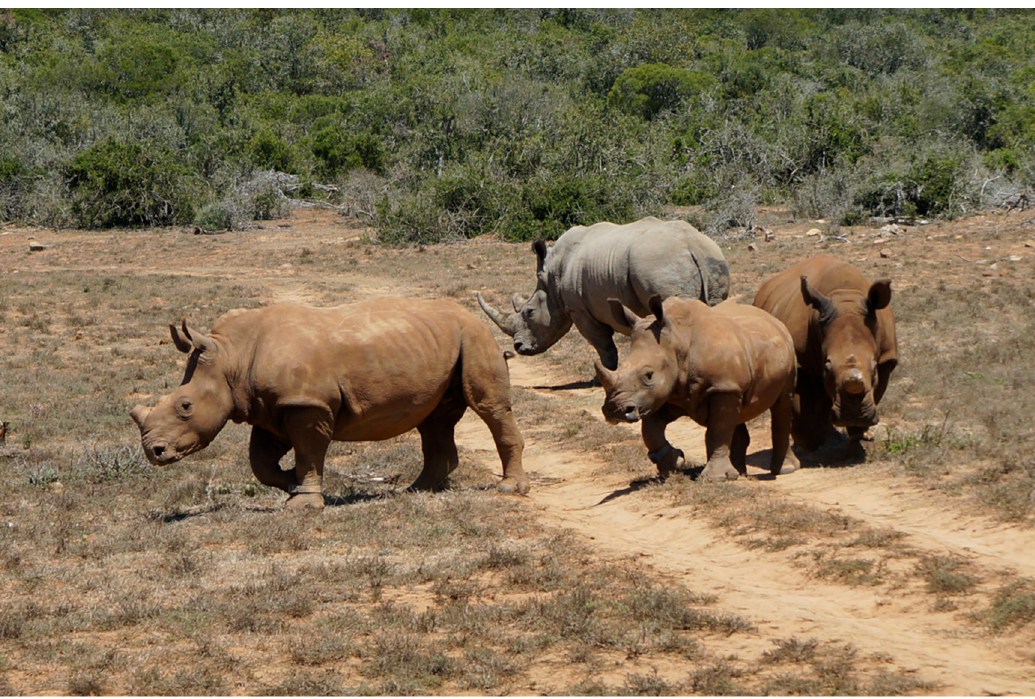
Figure 3. Three released females accompanied by a wild male 15 min post release.